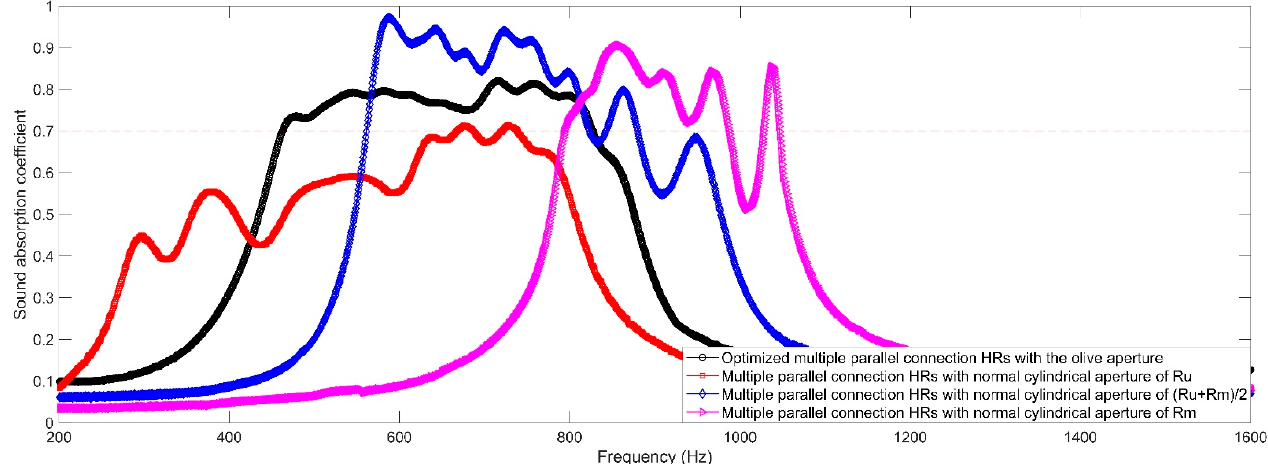
Figure 19. Comparison of sound absorption performances of the proposed acoustic metamaterial with those of the multiple parallel connection HRs with normal cylindrical aperture.